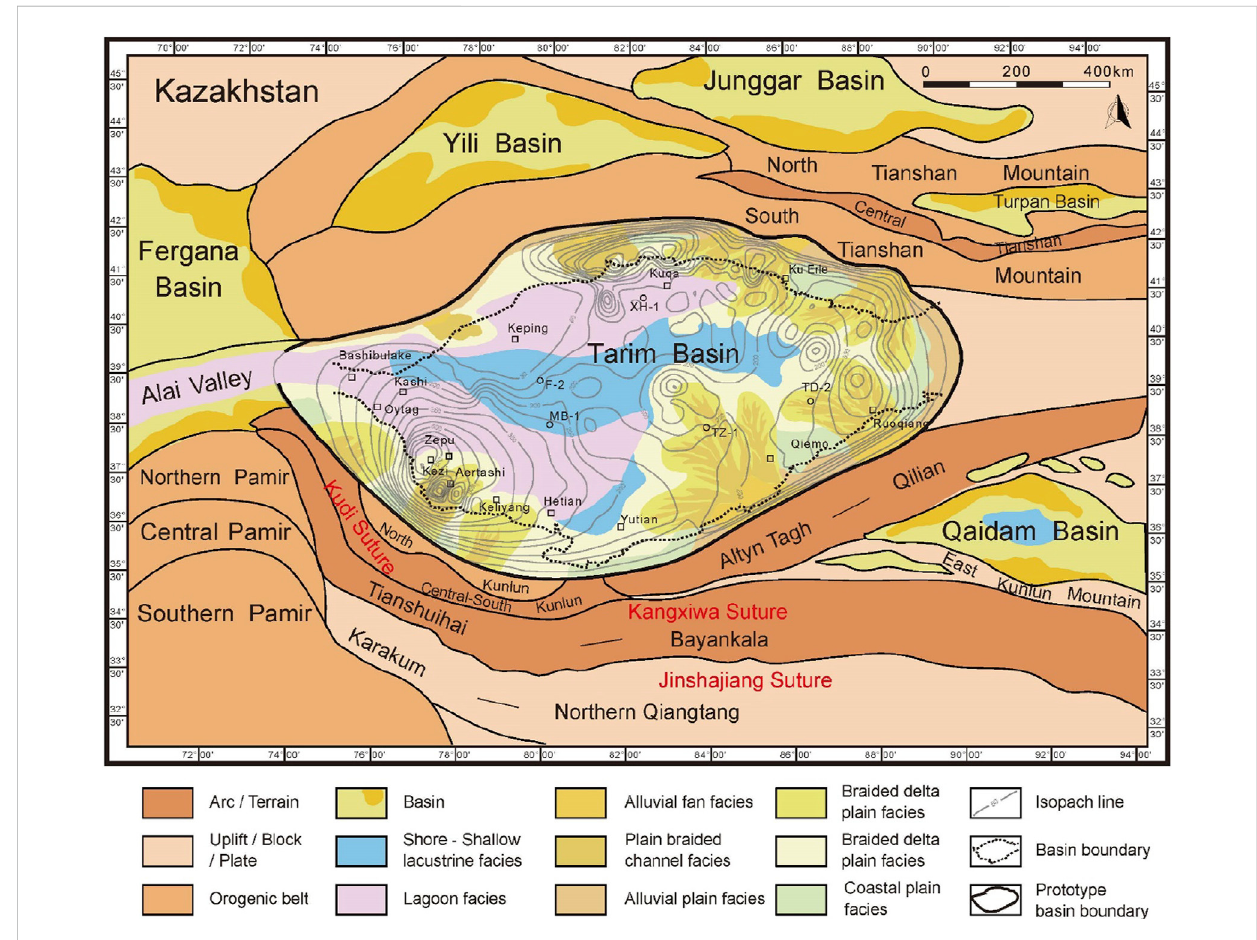
FIGURE 7 The Tarim proto-type basin and its periphery in the Late Oligocene. Thickness map contoursshow the depth (m) of the upper Eocene to Oligocene in the Tarim